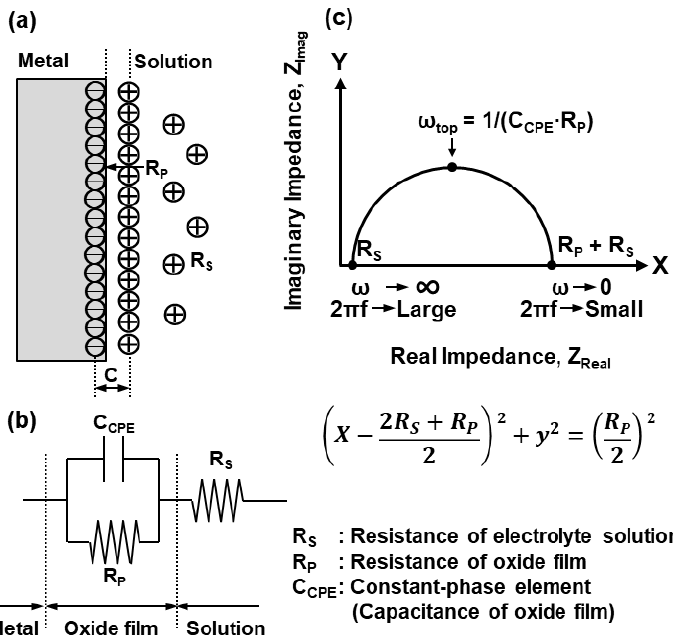
Figure 1. ( a ) Electrochemical model of oxide film, ( b ) equivalent circuit model of oxide film used to fit the impedance data, and ( c ) schematic illustration of Nyquist plot.